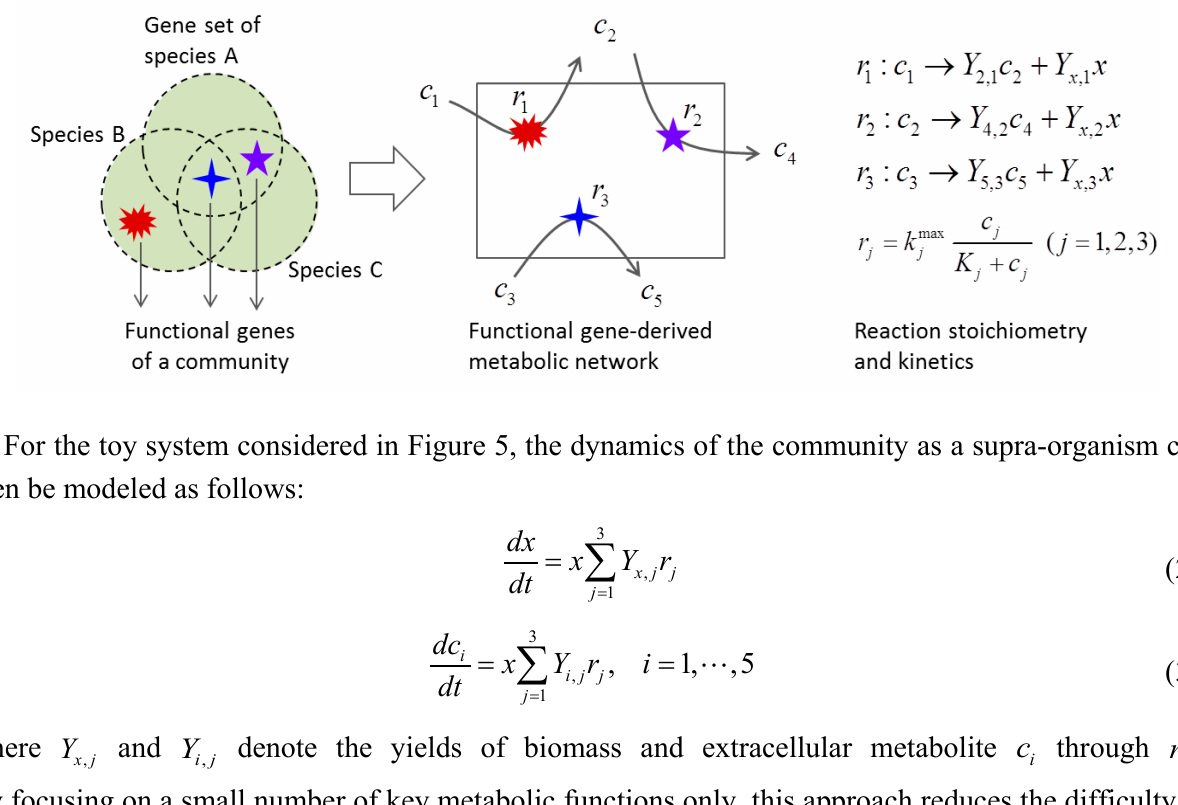
Figure 5. Function-based dynamic